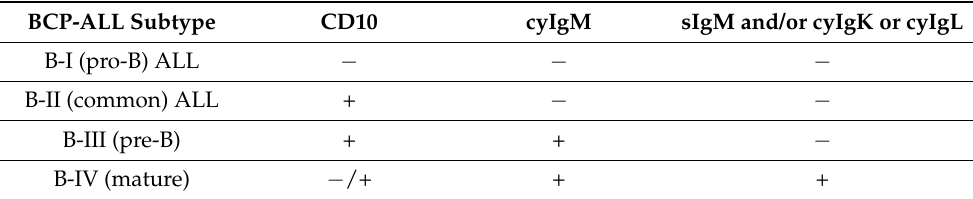
cyIgM—cytoplasmic IgM; sIgM—surface IgM; cyIgK—cytoplasmic Kappa light chain; cyIgL—cytoplasmic Lambda light chain. Additional subtype of BCP-ALL—Transitional pre-B-ALL subtype is characterized by presence of surface and cytoplasmic IgM but lack of cyIgK or cyIgL light chains